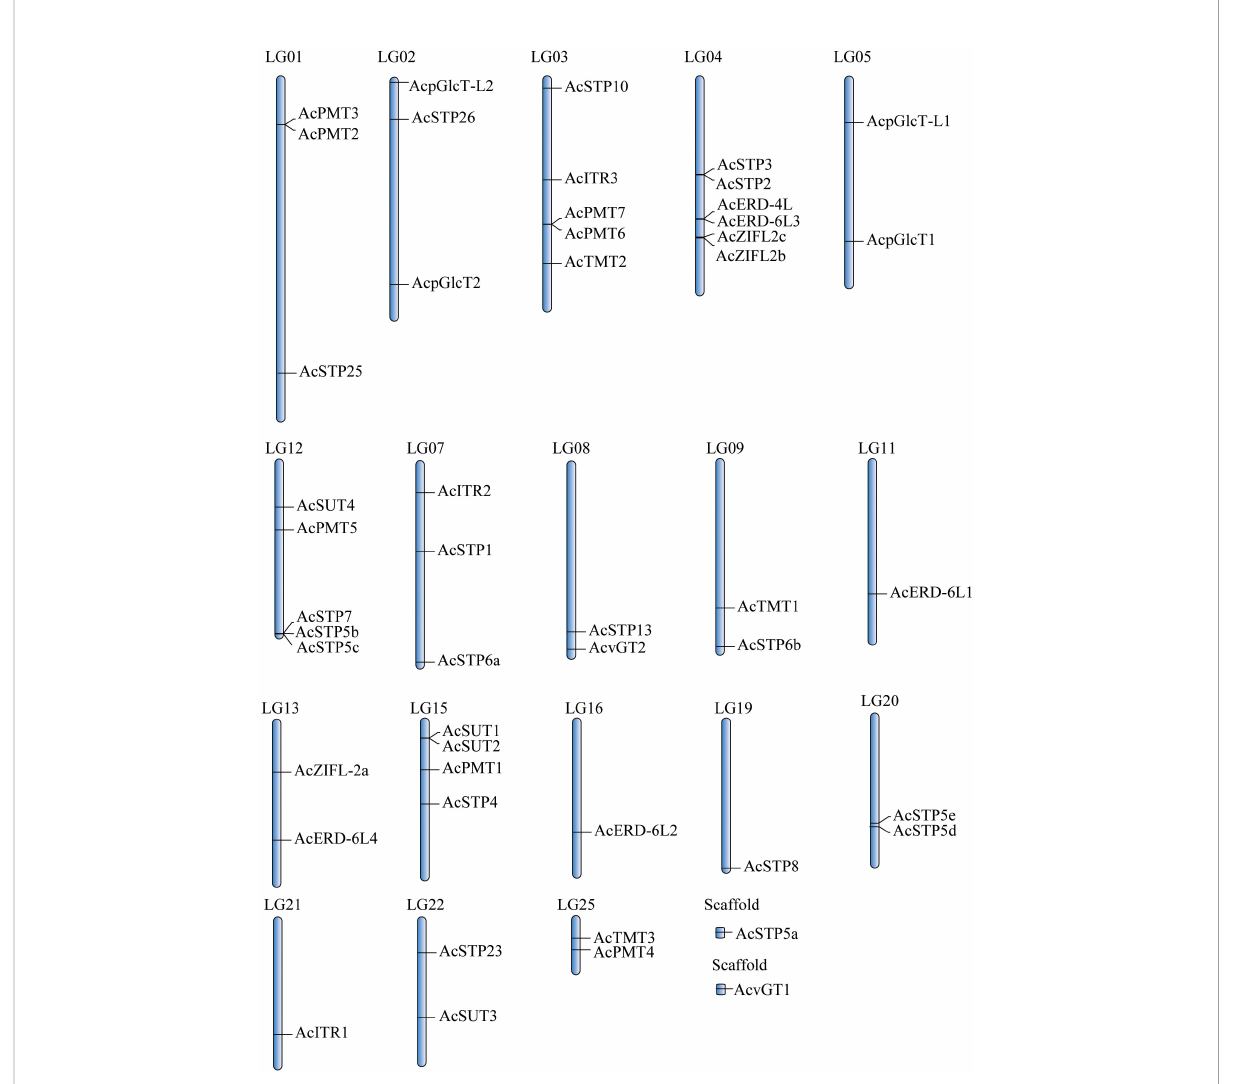
FIGURE 1 The distribution of sugar transporter genes in pineapple ( Ananas comosus )